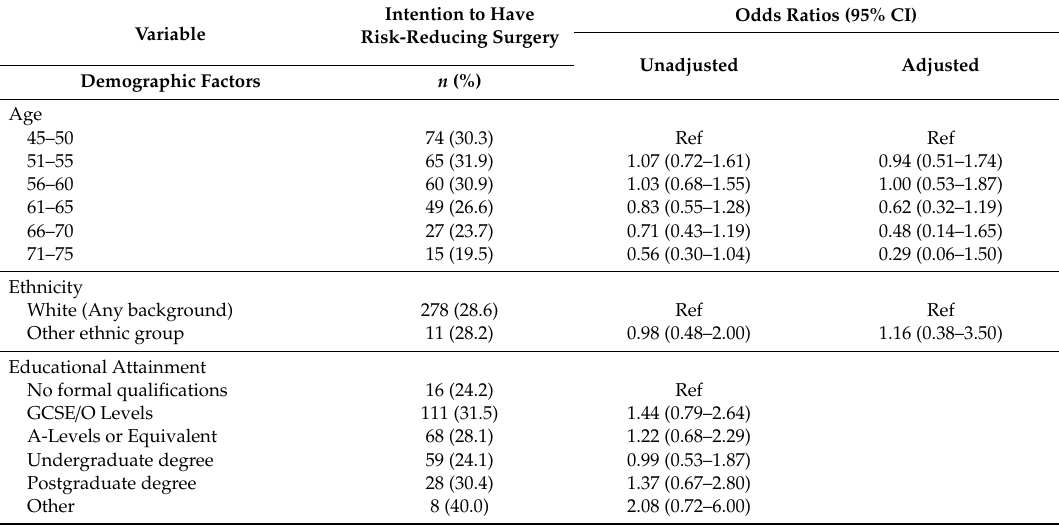
Table 2. Logistic regression predicting likelihood of intending to have risk-reducing surgery vs. other behavioural response ( n =